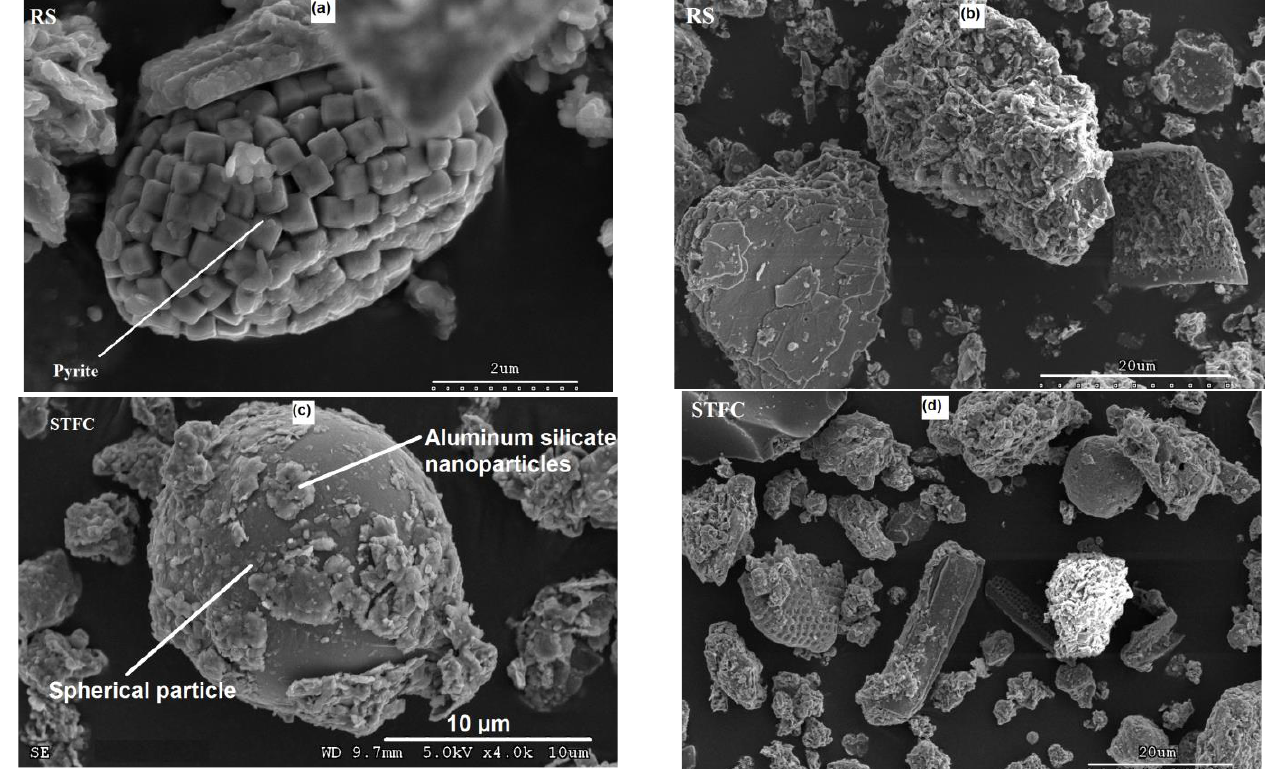
Figure 8. Electron microscopy of RS and treated STFC sediment. ( a ) Pyrite particle, ( b ) plate-like cemented particles, ( c ) Spherical aluminosilicate nanoparticle, ( d ) Organic particles and seashells.